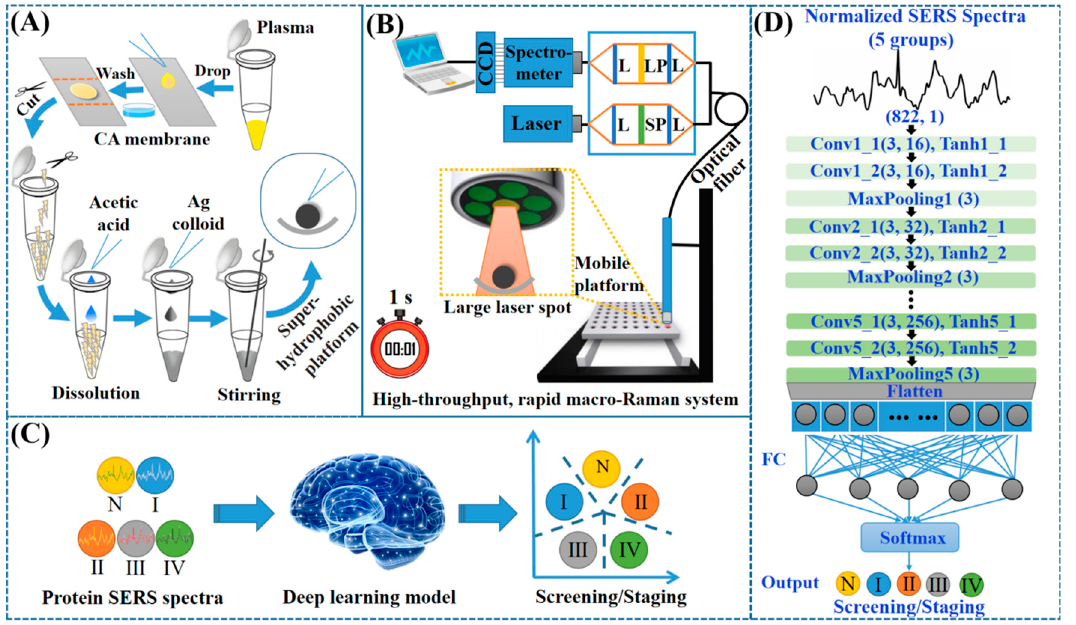
Figure 2. ( A ) Schematic of CA-membrane-based purification of plasma protein for SERS detection. ( B ) High-throughput, rapid macro-Raman system (abbreviations: L, lens; SP, short pass; LP, long pass). ( C ) Protein SERS spectra for NPC screening and staging using a deep-learning algorithm, and ( D ) structure of CNN-based deep-learning model (abbreviations: Conv, convolutional layer; FC, fully connected layer; N, normal; I, stage I NPC; II, stage II NPC; III, stage III NPC; IV, stage IV NPC).